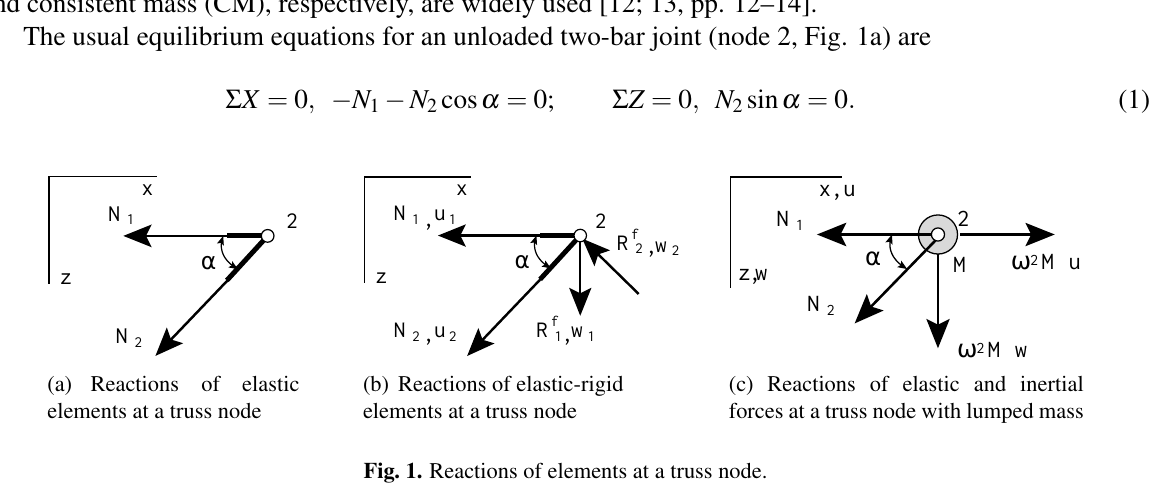
Fig. 1. Reactions of elements at a truss